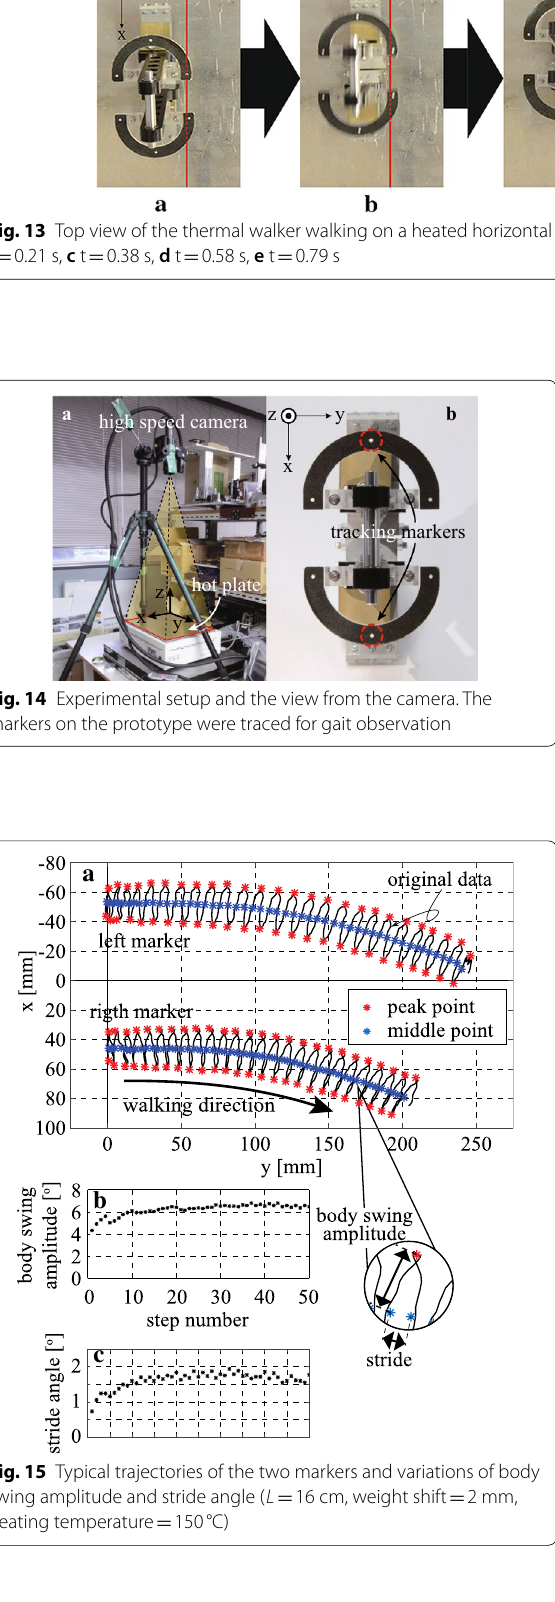
16 cm, weight shift 2 mm, = =